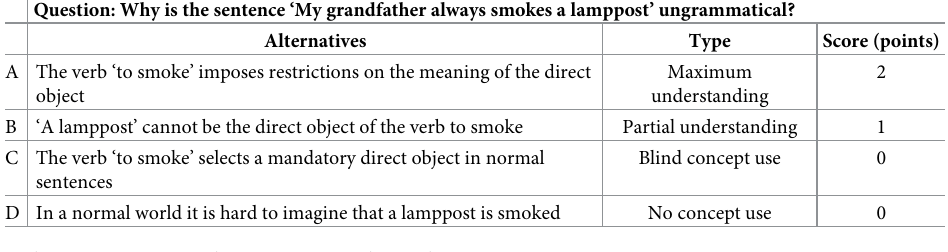
Table 2. Example of a question (see [29]) with the different multiple-choice options (translated from Dutch by the authors). Question: Why is the sentence ‘My grandfather always smokes a lamppost’ ungrammatical?